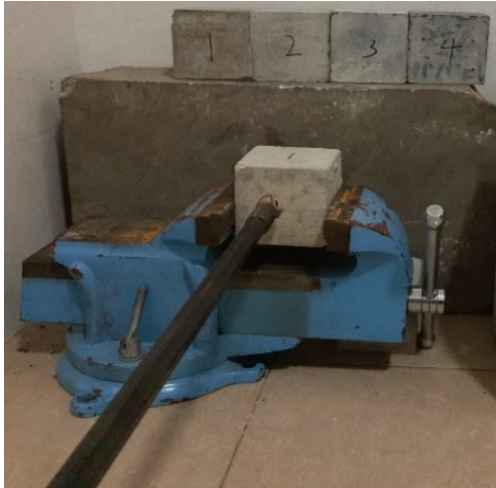
Figure 7. Concrete block. Table 2. Ratios of similar